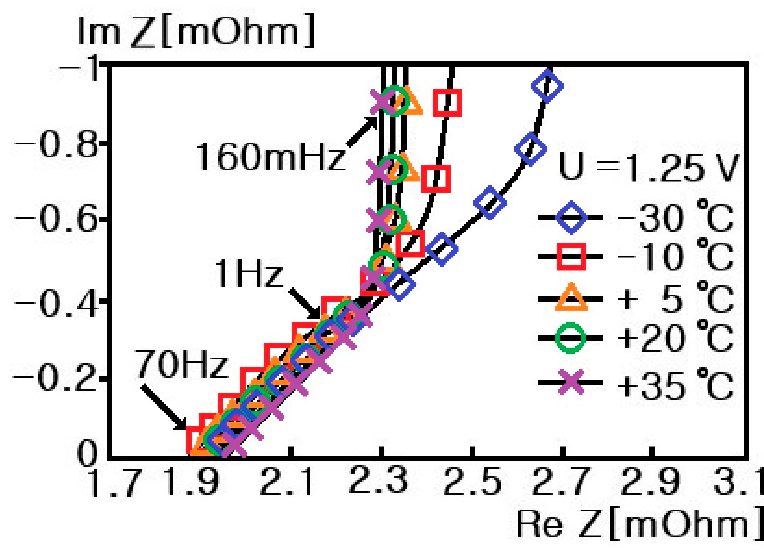
Figure 9. Impedance spectrum according to temperature of the supercapacitor [5,6].